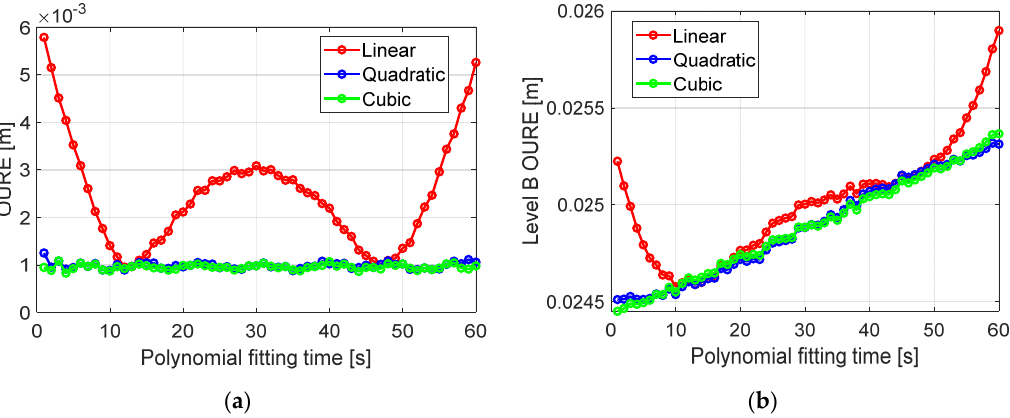
Figure 16. The OURE of ( a ) the polynomial fitting errors and ( b ) the total Level B orbital errors concerning the polynomial fitting time.